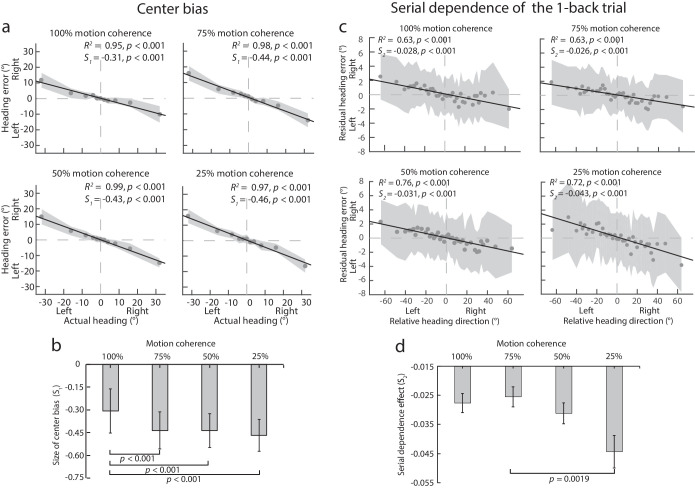

Experiment 2 data. (a) Mean observed heading error averaged across participants against actual heading. “Left” and “Right” on the x-axis indicates the actual heading to the left or right of the display center, and “Left” and “Right” on the y-axis indicates the observed heading error to the left or right of the actual heading. The shaded areas indicate ± 1 SD across 20 participants. The black solid lines show the best linear regression fits. (b) Mean size of center bias (S1) averaged across participants as a function of motion coherence level. Error bars are ± 1 SD across 20 participants. (c) Mean residual heading error against relative heading between the first previous trial (i.e. the 1-back trial) and the current trial. “Left” and “Right” on the x-axis indicate that the presented heading of the previous trial was to the left or right of the presented heading of the current trial. “Left” and “Right” on the y-axis indicate that the perceived heading was to the left or right of the predicted perceived heading. The shaded areas indicate ± 1 SD across 20 participants. The black solid lines show the best linear regression fits. (d) The repulsive serial dependence effect (S2) as a function of motion coherence level. Error bars are ± 1 SD of the distributions of S2 estimates generated by bootstrapping the fitting of the linear regression line 10,000 times relying on sampling from participants’ mean residual heading error data with replacement on each iteration.